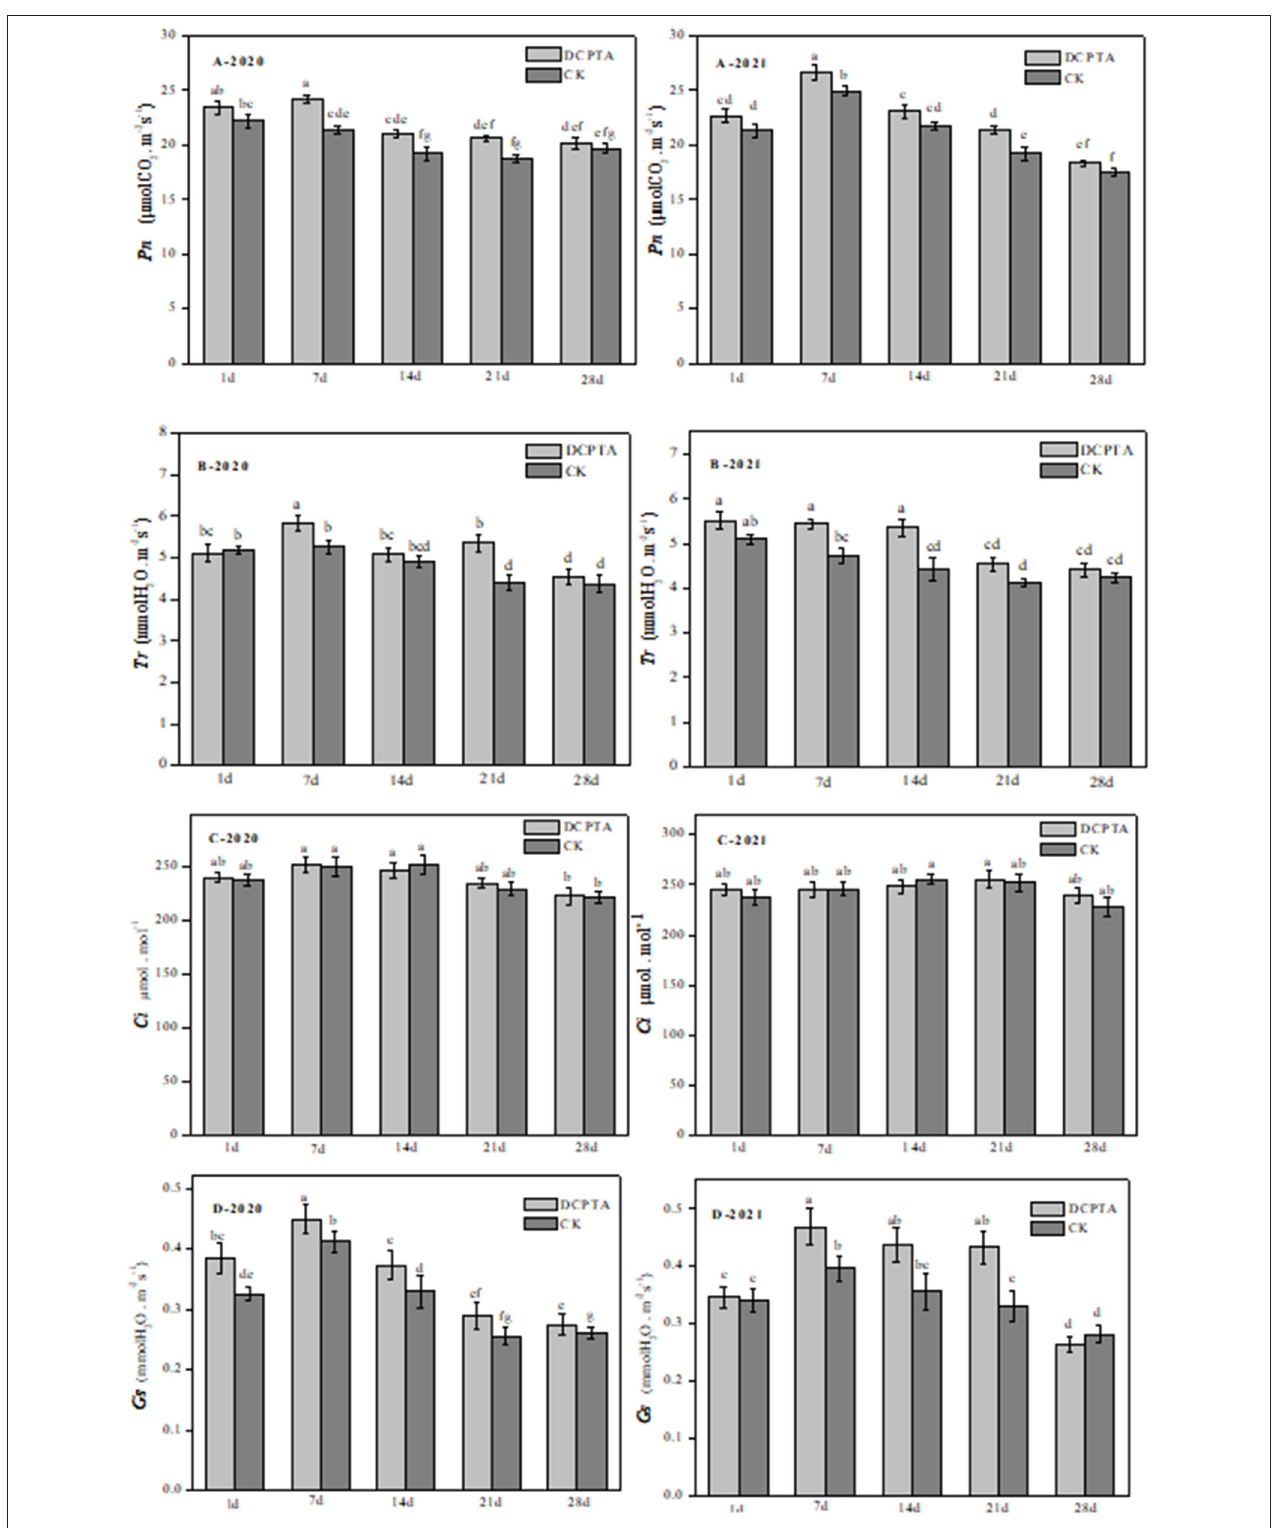
FIGURE 1 | The effects of DCPTA on Pn, Tr, Gs, and Ci in leaves from 2020 to 2021. (A) Pn; (B) Tr; (C) Ci; and (D) Gs at 1–28 days after spraying. Data were analyzed by ANOVA to separate significance. Vertical bars represent mean ± SE from three independent replicates and the different letters denote significant differences ( p <